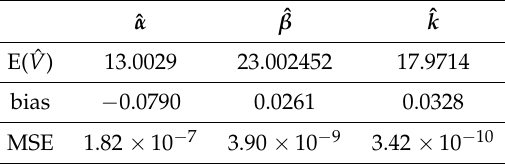
Table 14. Conjugate gradient method.